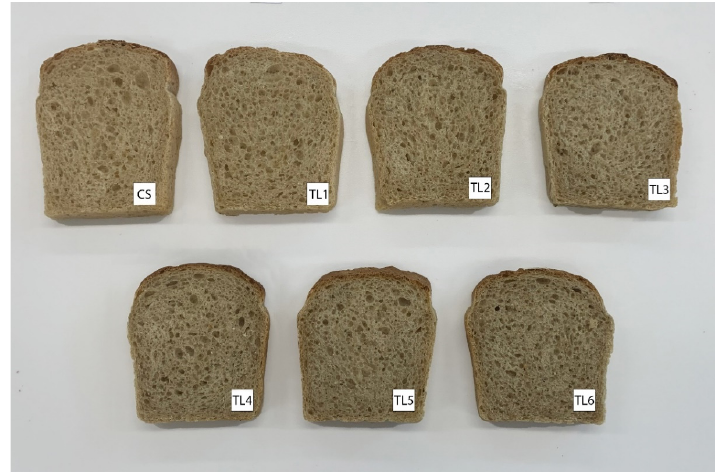
Figure 1. Appearance of wheat bread with different amounts of Taraxacum officinale.